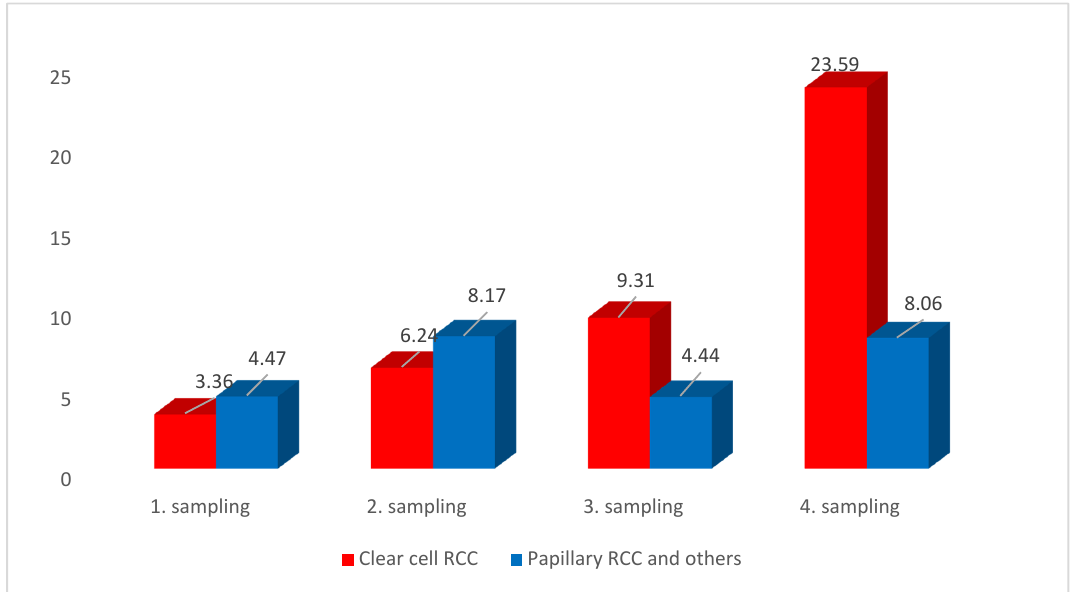
Figure 2. Circulating tumor cells (CTCs) detected in renal cell cancer (RCC) patients for one-year follow-up in four blood samplings. All together 495 samples (in duplicates) were evaluated, with an average 86.6% CTC positivity rate.